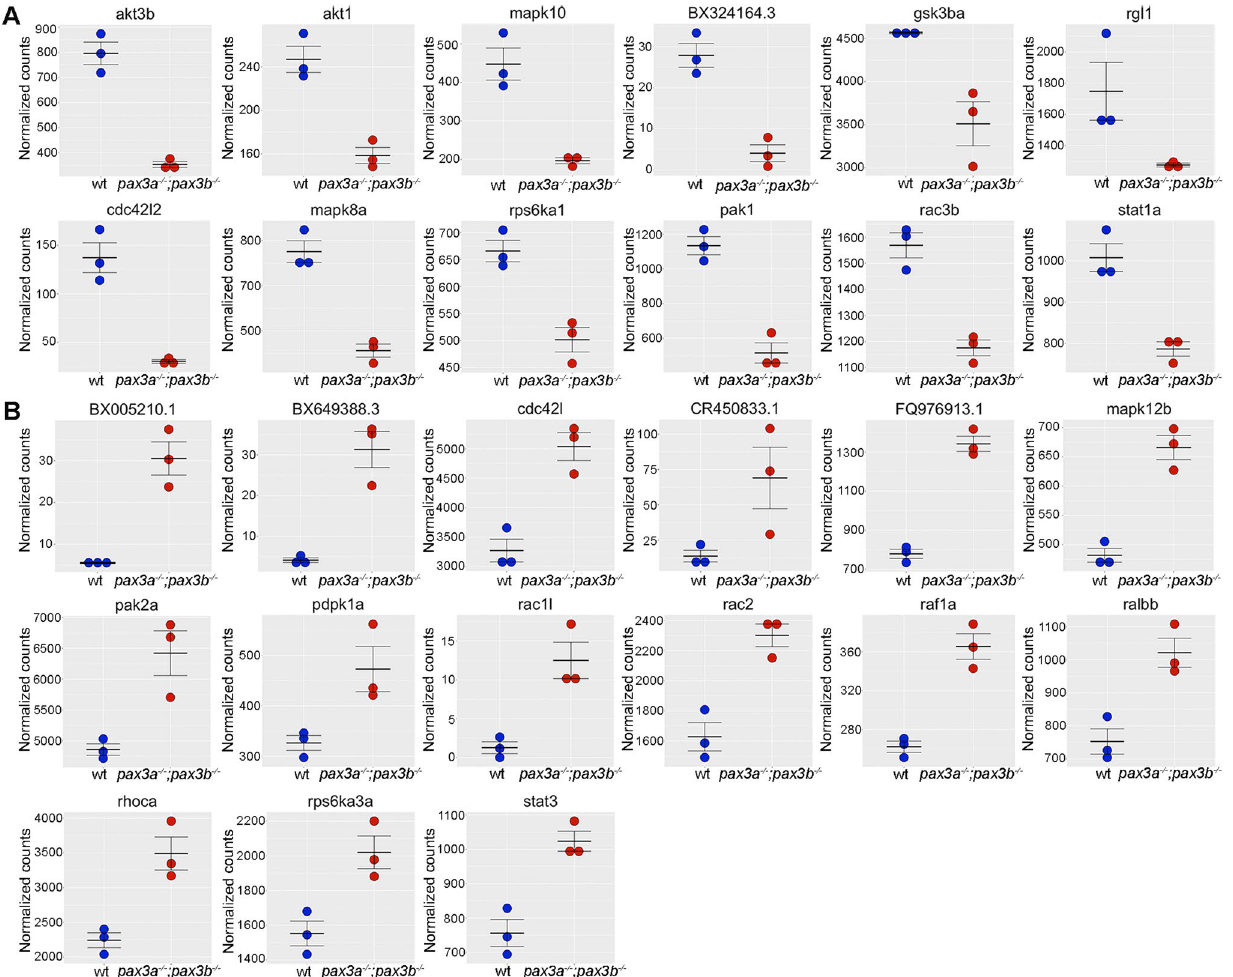
Figure 2. Expression of RAS/MAPK signalling pathway linked genes in wildtype (wt) and pax3a −/− ;pax3b −/− mutant zebrafish embryos: (A) Plots of down-regulated genes: akt1 , pak1 , mapk10 , rps6ka1 , cdc42l2 , mapk8a , rac3b , akt3b , BX324164 , rgl1 , stat1a and gsk3ba. (B) Plots of up-regulated genes: raf1a, rps6ka3a , pak2a , FQ976913 , ralbb , rac2 , CR450833 , pdpk1a , stat3 , BX005210 , BX649388 , mapk12b , rhoca , cdc42l and rac1l. The normalized counts of each gene in wild type and pax3a −/− ;pax3b −/− mutant is